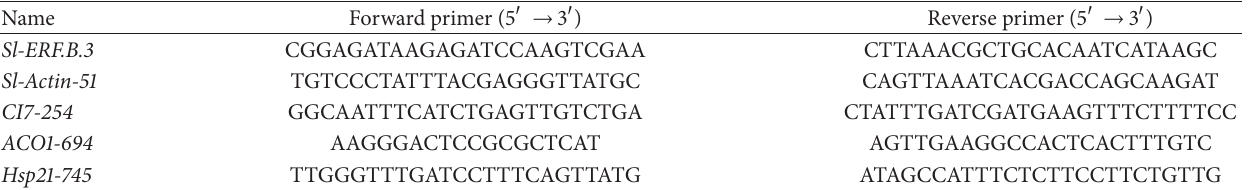
Table 1: Primer sequences for expression